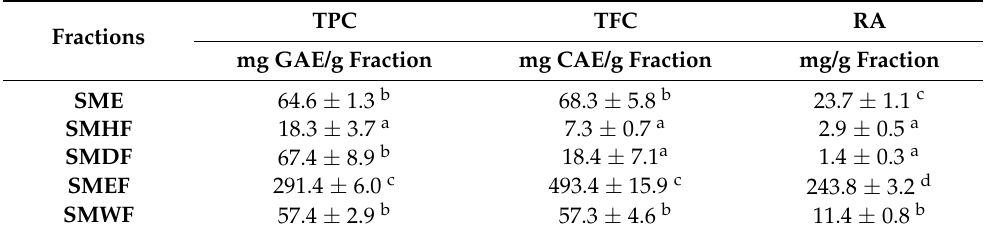
Table 3. Total phenolic content (TPC), total flavonoid content (TFC), and RA content of PSM